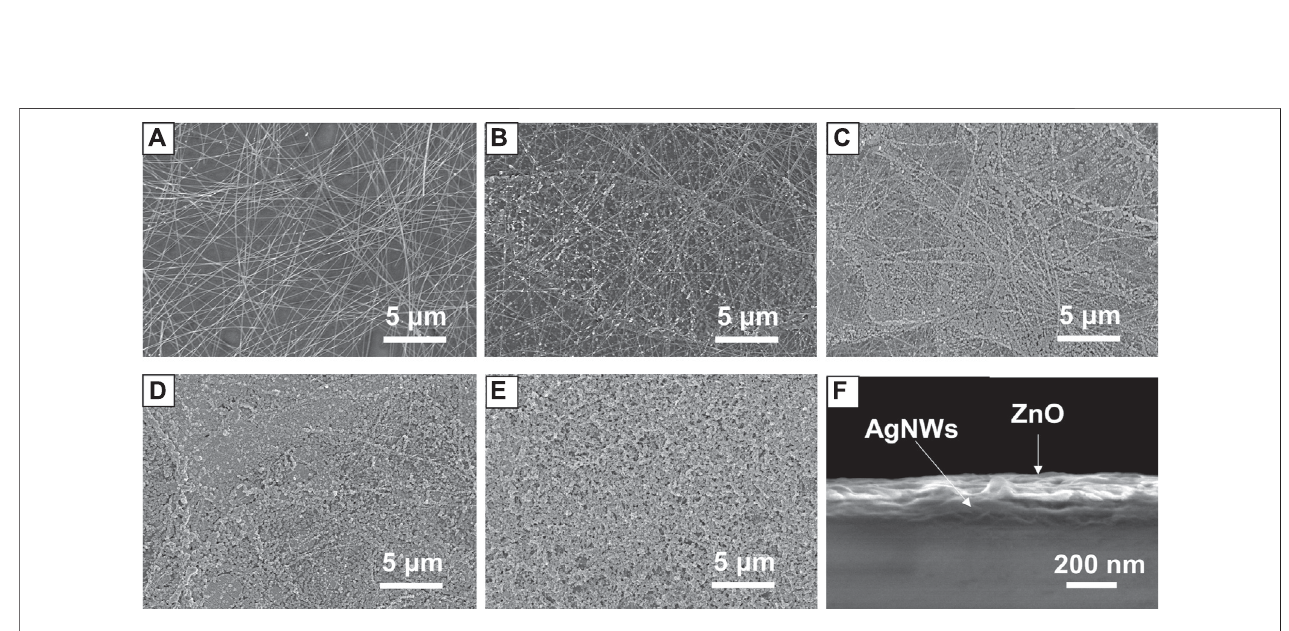
FIGURE 2 | Morphology of AgNWs/ZnO fi lms. SEM micrographs of (A) AgNWs fi lms and AgNWs/ZnO fi lms with ZnO thicknesses of (B) 30 nm, (C) 60 nm, (D) 90 nm, and (E) 120 nm; (F) cross-section view of a AgNWs/ZnO fi lm with a 90 nm-thick ZnO.